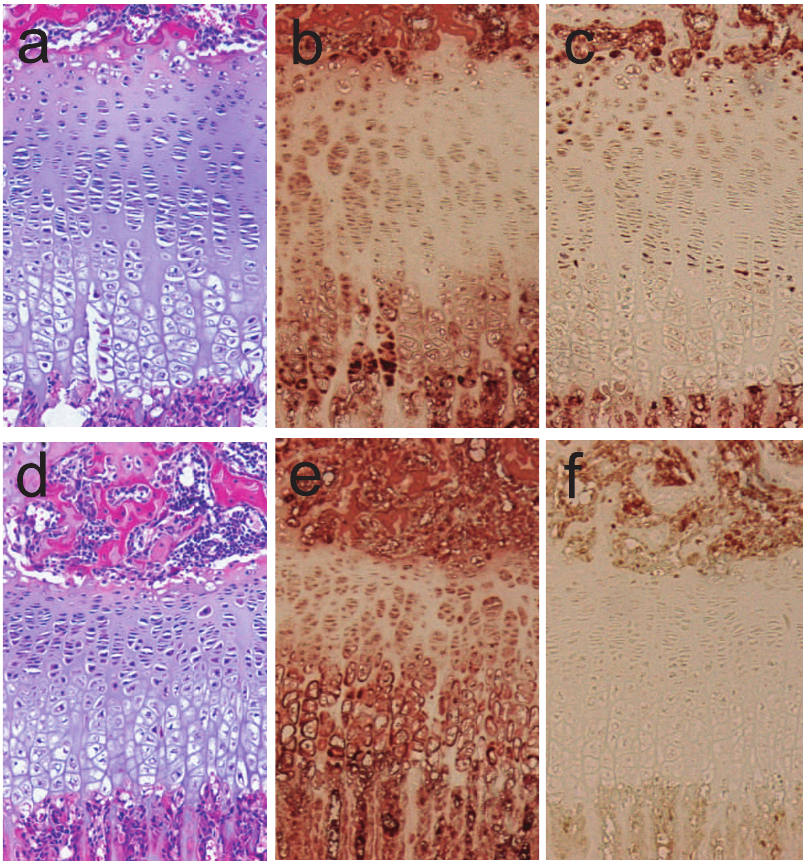
Figure 5. Histological analysis of long bones of p38 a mutants. A, B, and C are stained histological sections from a 4 week old male MAPK14 loxp/loxp control; D, E and F are from a male MAPK14 loxp/loxp ;Col2a1-cre littermate. A, D, H&E staining; B, E, ColX immunostaining; C, F, p38